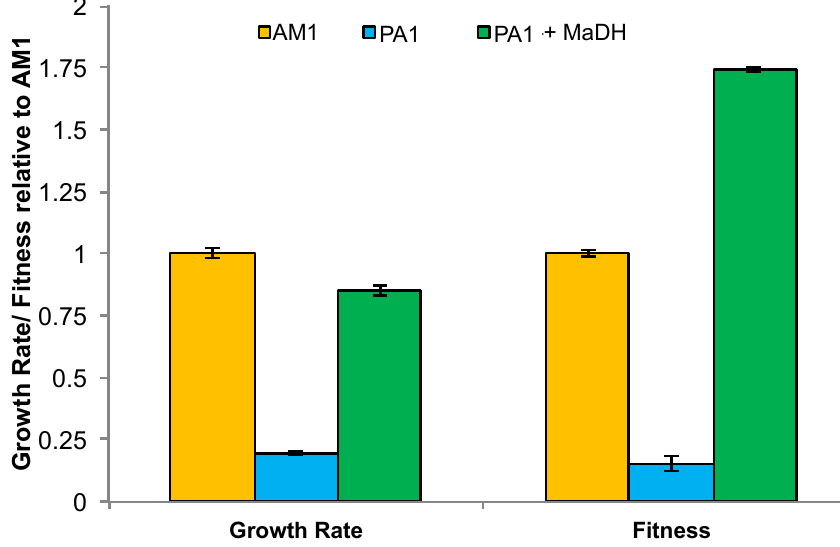
Figure 6. Methylamine growth rate and fitness of AM1 (light brown), PA1 (dark gray), and pAYC139 + PA1 expressing methylamine dehydrogenase (light gray) relative to AM1 (for growth rate) or mCherry AM1 (for fitness). Error bars each depict the 95% C.I. from three biological